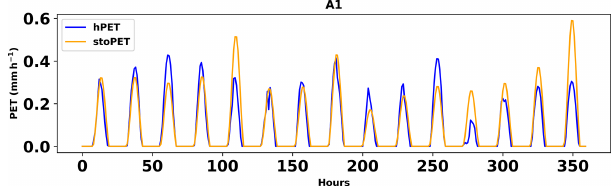
Figure 12. Time series of hPET and stoPET data for the last 15d of 2020 (for A1 in Fig. 7). The figure indicates that stoPET capture the diurnal cycle of PET, and the difference among each day is an expression of the stochasticity of the